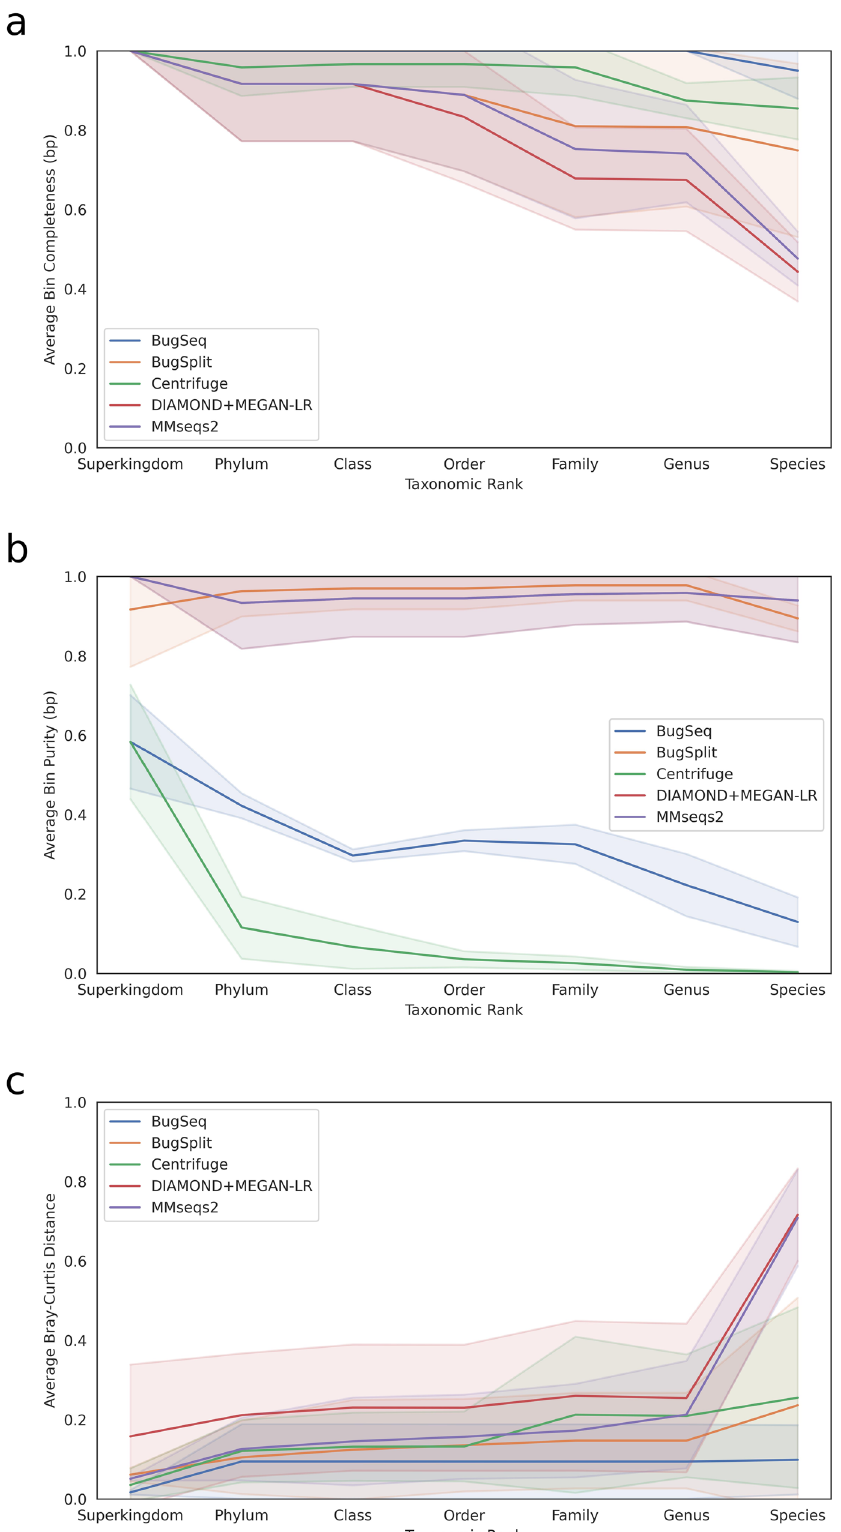
Fig. 3 Taxonomic pro fi ling accuracy of fi ve tools across three mock microbial communities sequenced with a long-read sequencer. a Greater bin completeness re fl ects better taxonomic pro fi ling. b Greater bin purity re fl ects better taxonomic pro fi ling. c Lower Bray-Curtis distance re fl ects better taxonomic pro fi ling. Shaded bands show the standard error of the metrics in a , b , and c